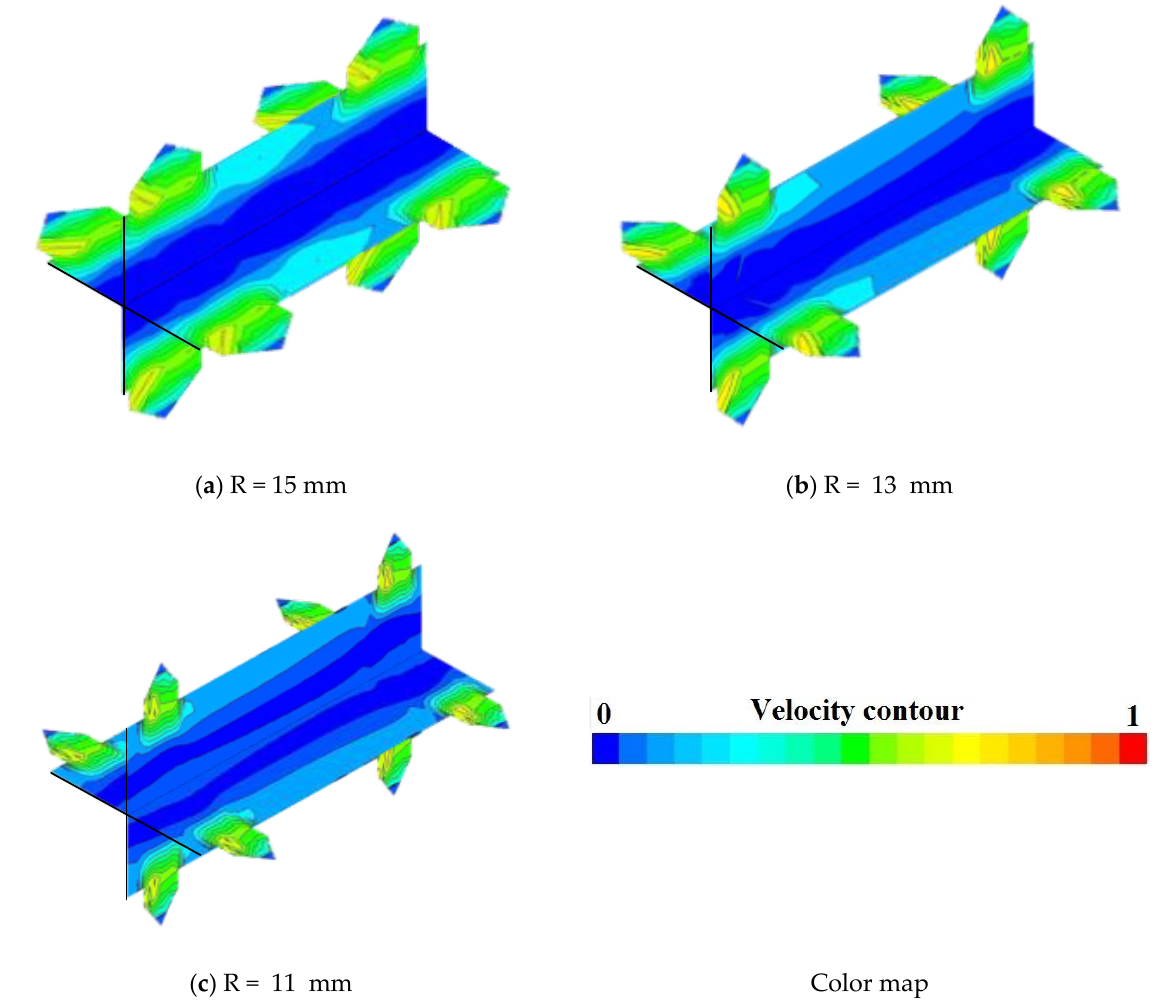
Figure 7. Velocity magnitude contours for various configurations of Case A with different R parameters at A 2 = 24 mm, Re = 15,000, and 𝜑 = 0.5%.